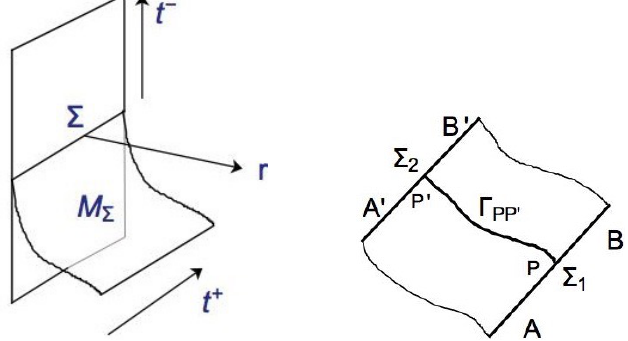
Figure 1 . The relation between the codimension one surface M (cid:6) and where it ends on (cid:6) could be the same as those of [30] shown in the left side and the quantum circuit modeled by the path- integration on M (cid:6) connecting (cid:6) 1 to (cid:6) 2 is modeled in the right side. We show however later 1 (cid:6) 2 that a twist is needed to be considered for the WCFT/WAdS